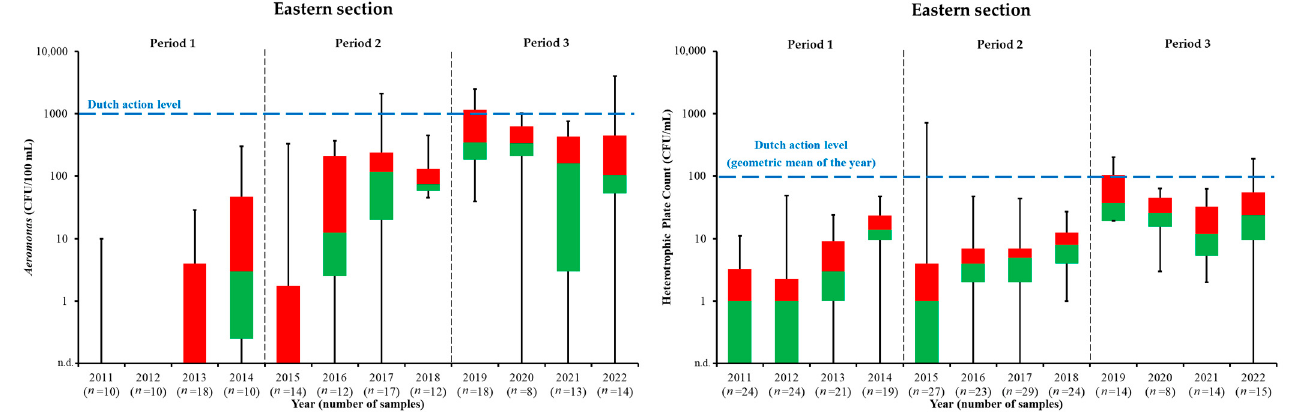
Figure 5. Boxplots of Aeromonas ( Left ) and HPC22 ( Right ) in the eastern section of DWDS Zeeuws-Vlaanderen. (cid:4) : second quartile; (cid:4) : third quartile; T: first and fourth quartile; n.d.: not detected.